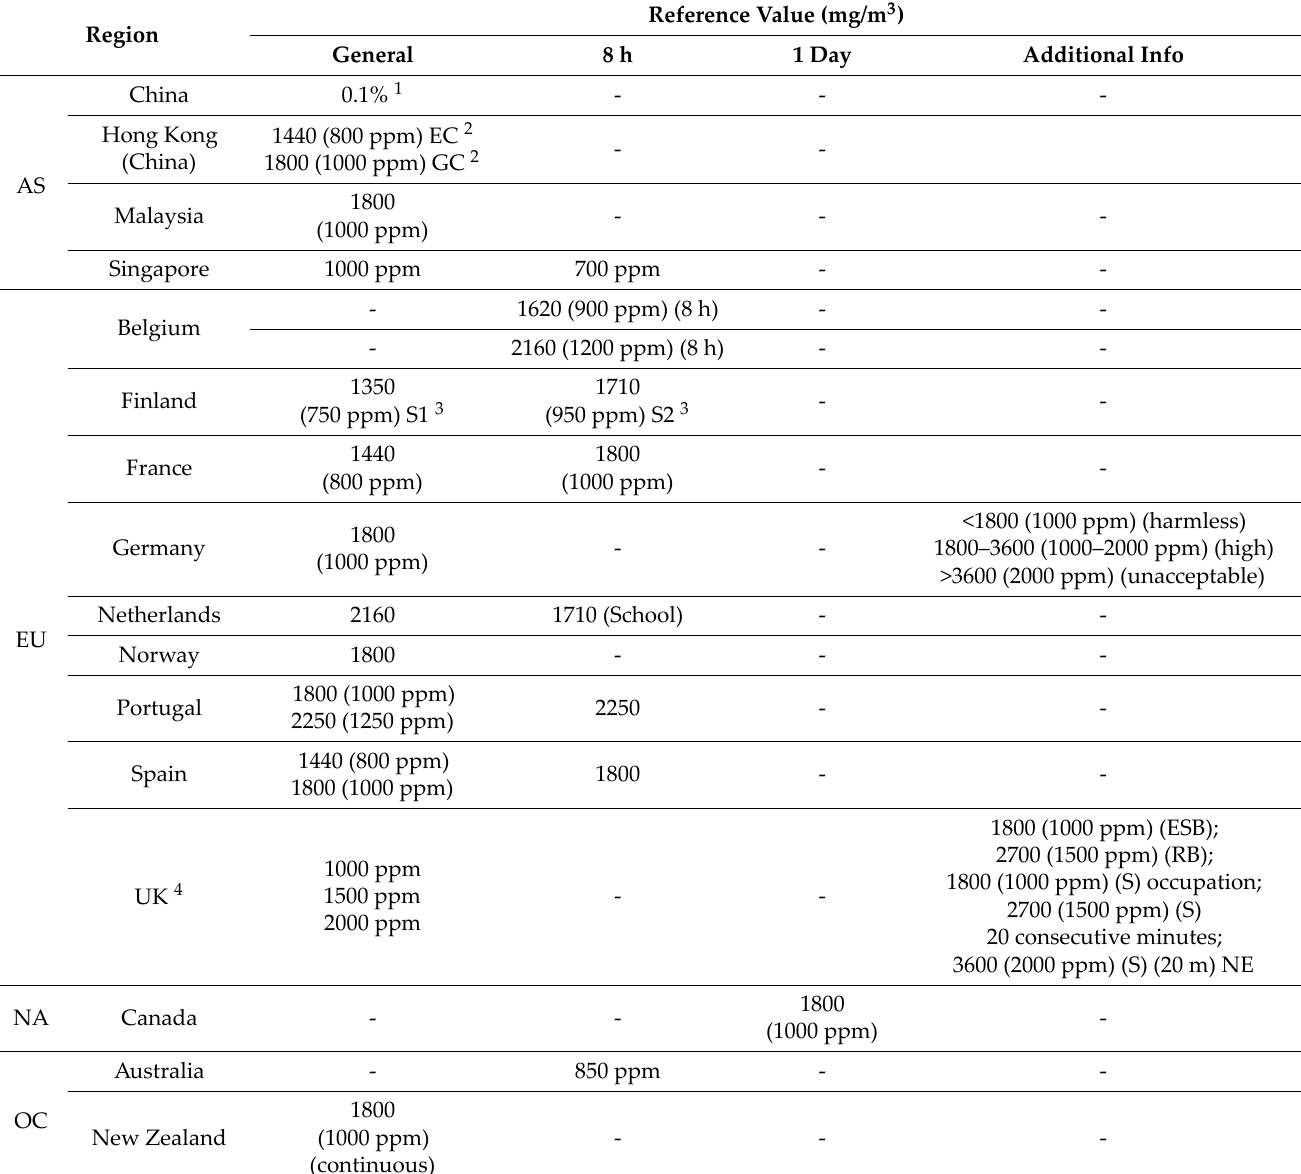
Table 6. Reference values for carbon